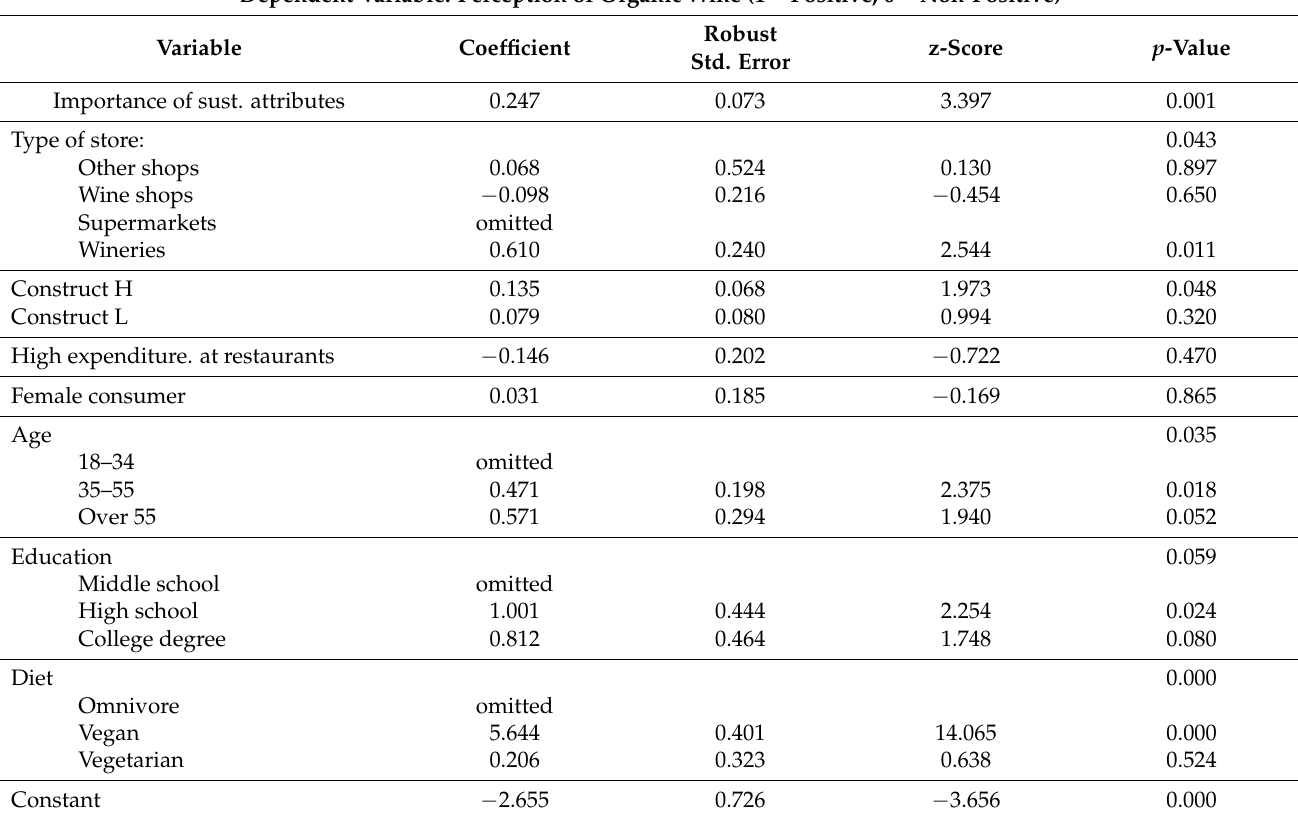
Table 4. The results of the probit regression results of perception of organic wine on a set of explana- tory